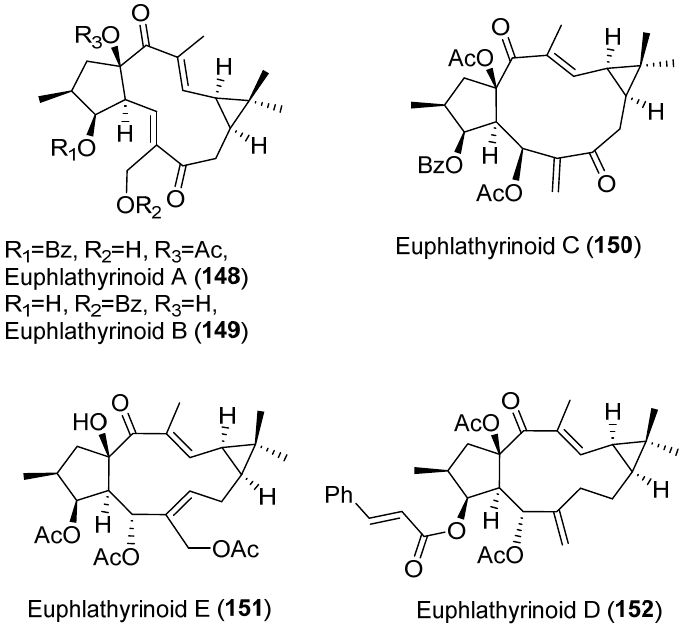
Figure 27. Compounds with anticholestasis